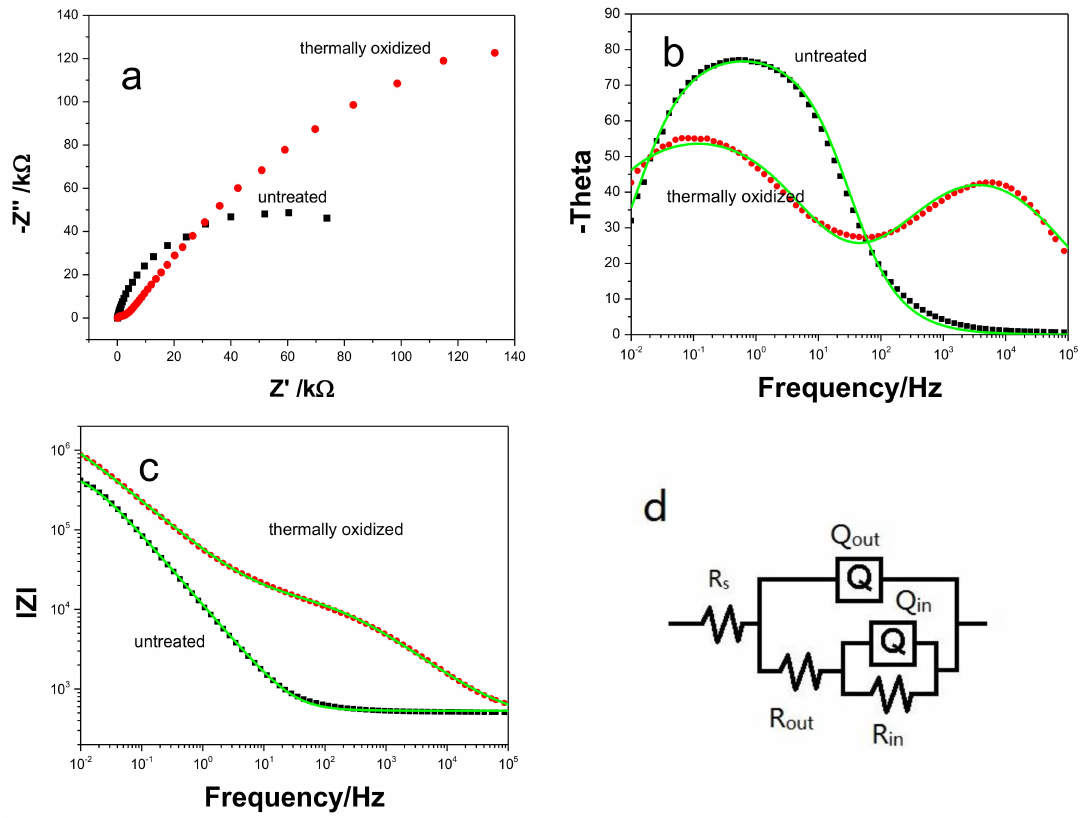
Figure 4. Electrochemical impedance spectroscopy (EIS) results for untreated and thermally oxidized Ti6Al4V sample: ( a ) NY Quist plots (Z (cid:48) and Z” mean the real part and imaginary part of impedance under different frequency); ( b ) bode impedance plots (theta mean the phase angle of impedance under different frequency); ( c ) bode theta-angle plots (lzl mean the module value of impedance under different frequency); and ( d ) equivalent circuit